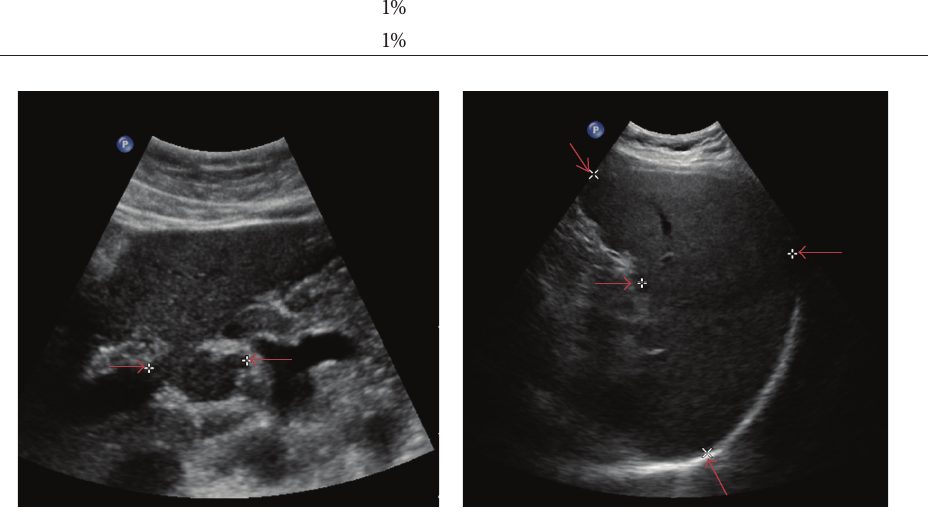
Figure 1: Abdominal ultrasound demonstrating lymphadenopathy and splenomegaly. (a) The lymph node diameter (3.1cm) is demarcated by the arrows. (b) The spleen dimensions (18.3 cm × 9.3 cm) are demarcated by the arrows.